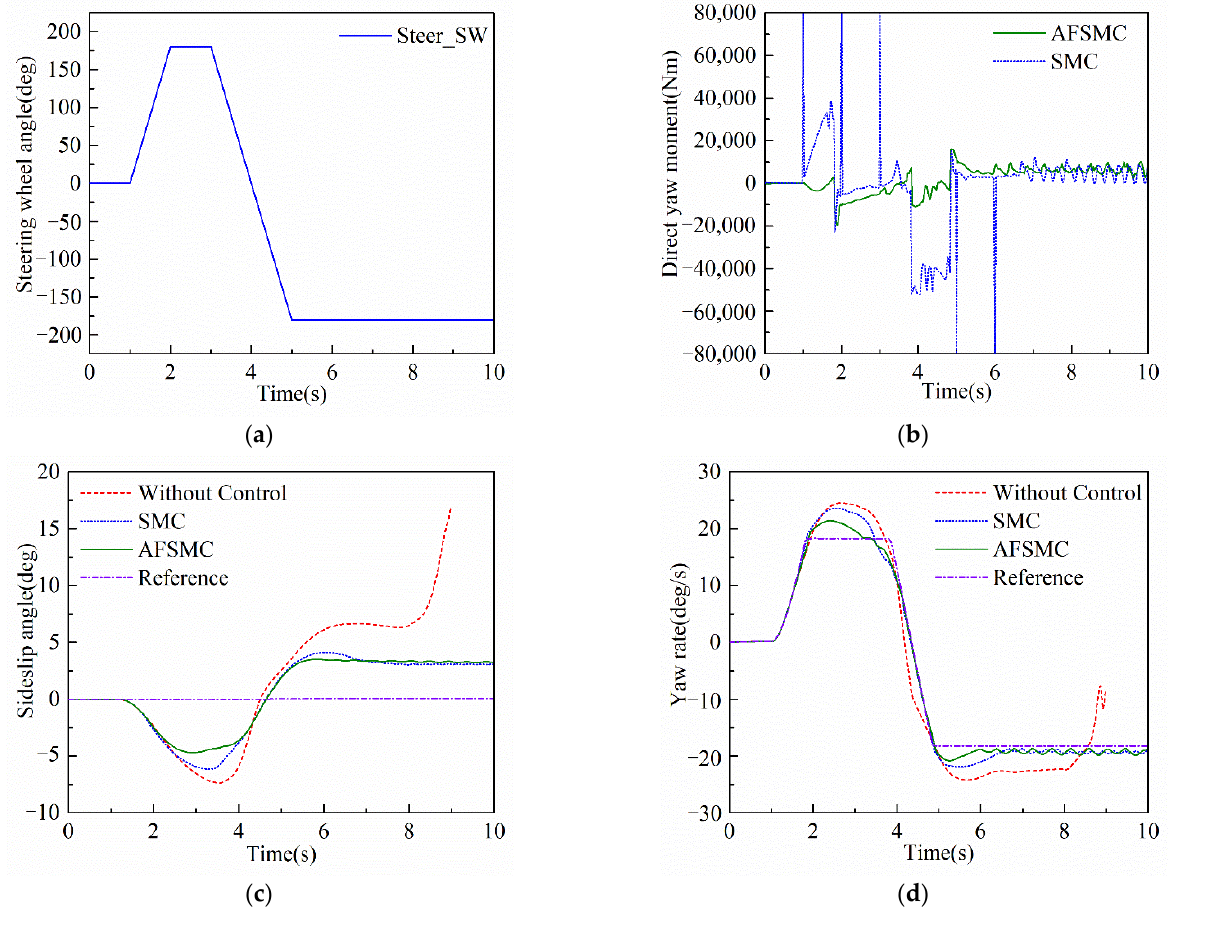
Figure 9. The simulation results of the fishhook response test. ( a ) Steering wheel angle; ( b ) direct yaw moment; ( c ) sideslip angle; ( d ) yaw rate.